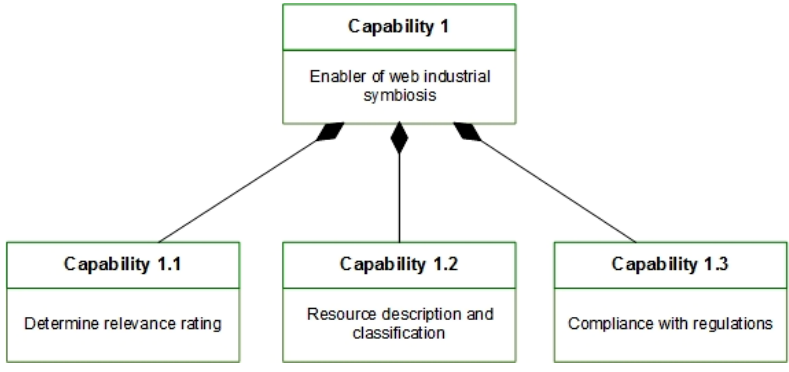
Figure 1. Excerpt from the capability model for the symbiosis